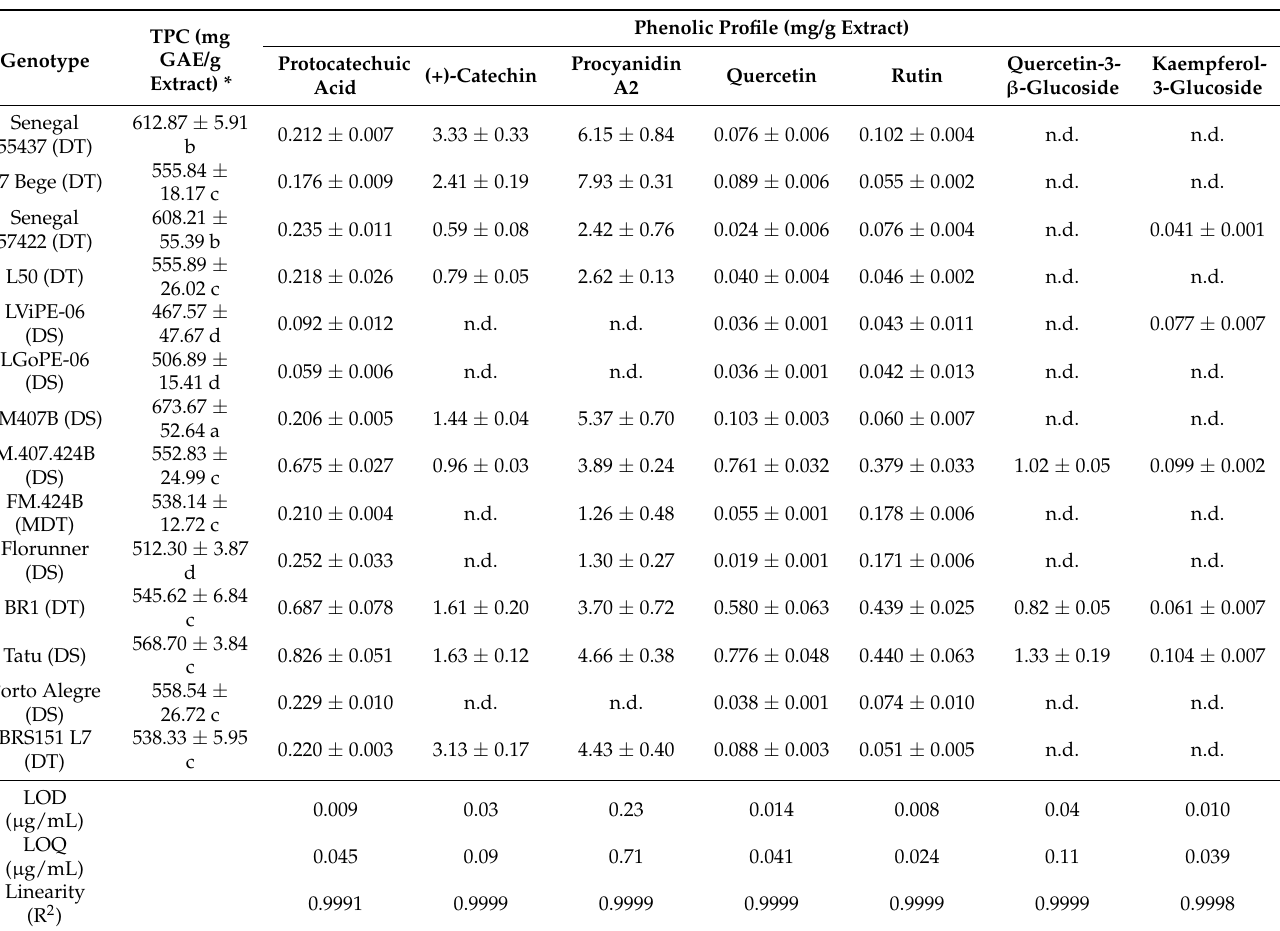
Table 3. Total phenolic content (TPC) and quantification using HPLC-PDA of phenolic compounds in optimized skin extracts of peanut genotypes with varying levels of drought